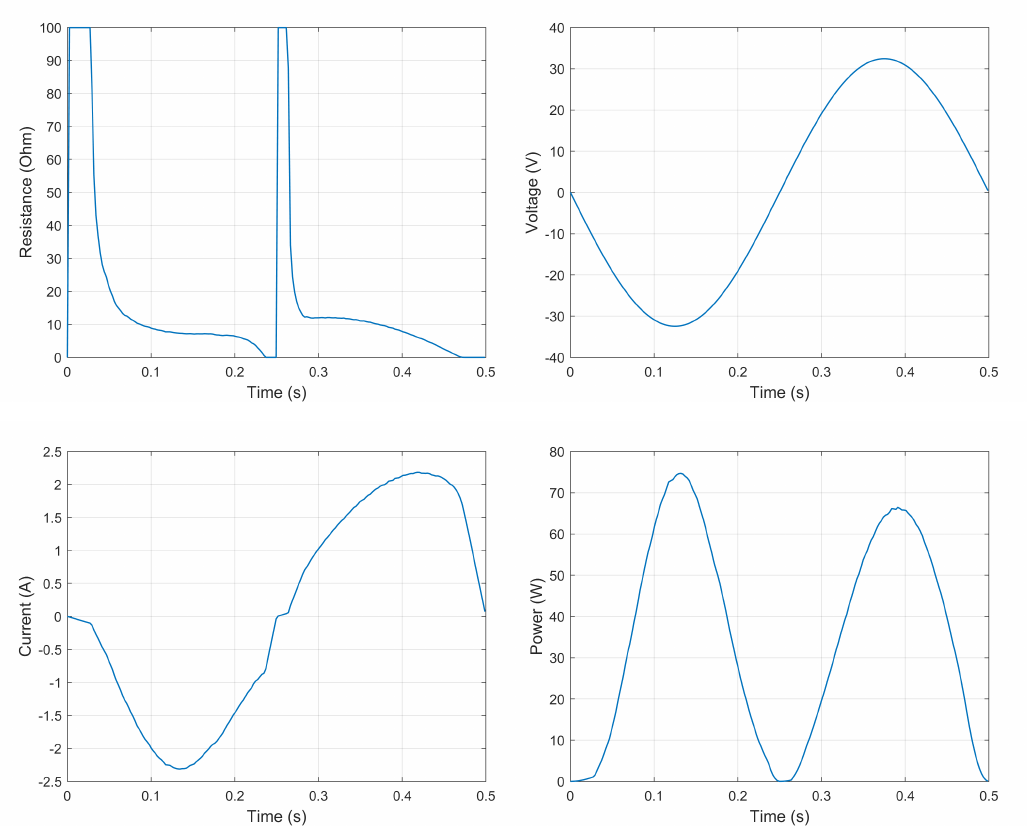
Figure 7. Values of the external resistance, generated voltage, current and power dissipated along one test cycle.